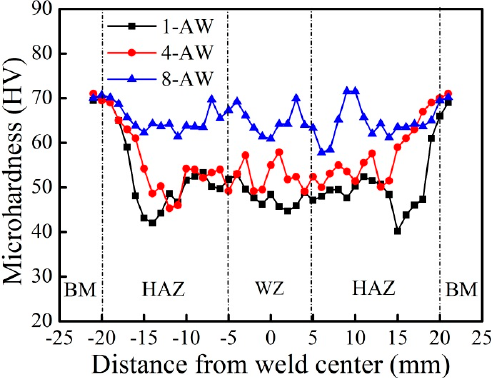
Figure 6. Microhardness distribution across the as-welded joint as a function of heat input during welding (AW: As-welded; BM: Base metal; HAZ: Heat-affected zone; WZ: Weld zone).